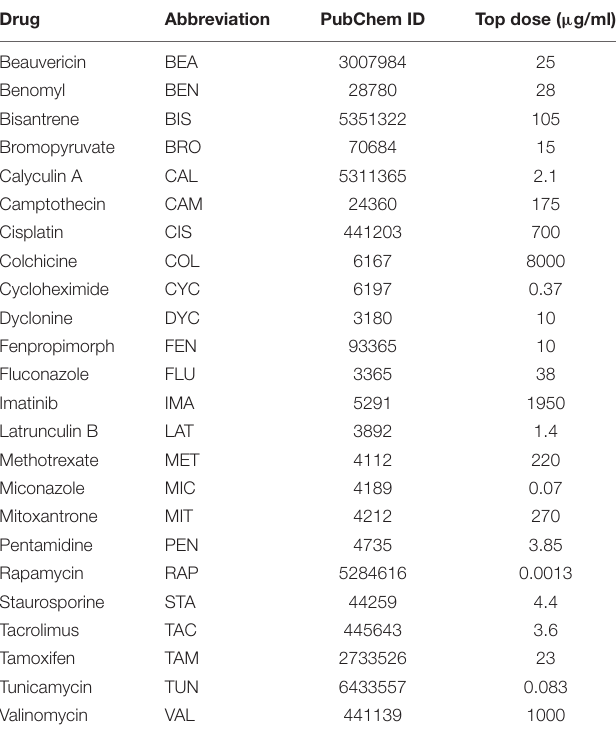
TABLE 2 | Name, abbreviation, PubChem ID, and top dose for each of the 24 drugs used for the prospective validation